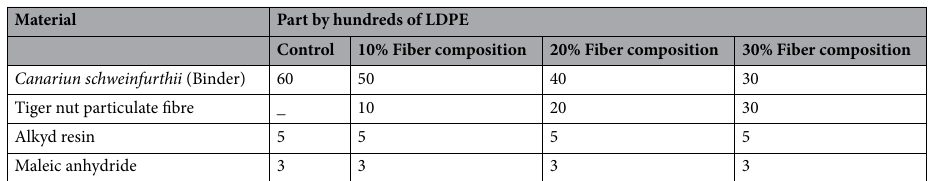
Table 1. Formulations of composites fabrication with the particulate